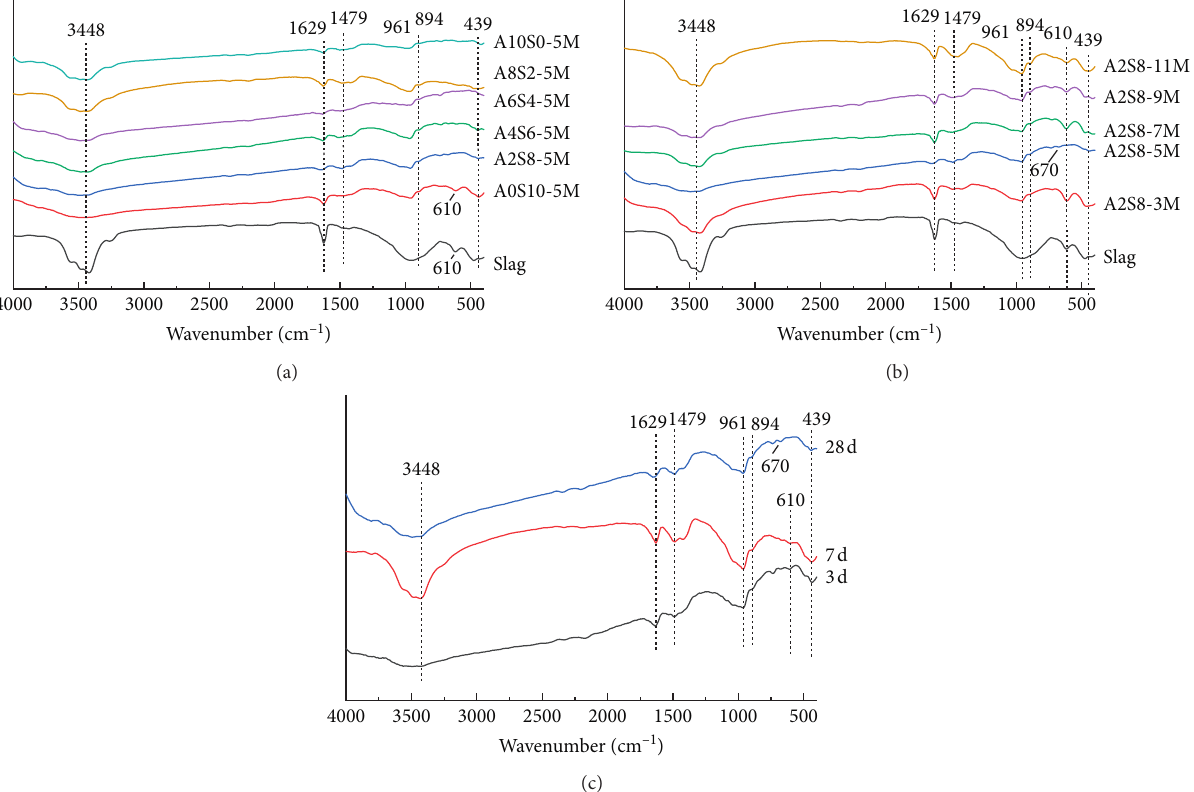
Figure 12: FT-IR spectra of AAS and raw slag. (a) Different NaAlO time; and (c) A2S8-5M at 3, 7, and 28d curing